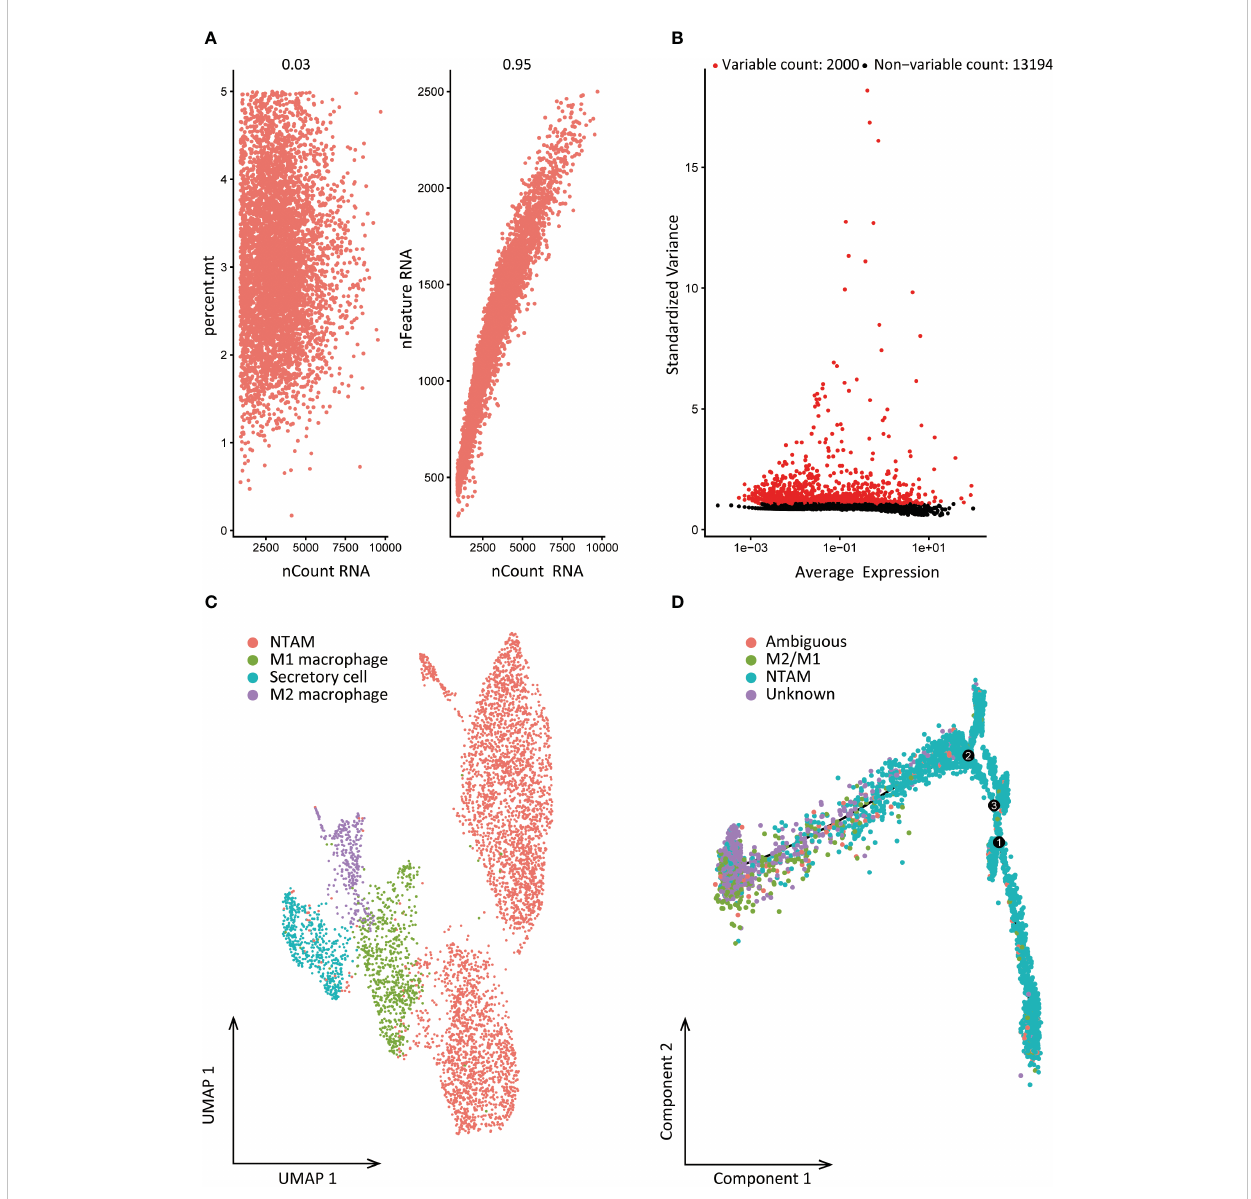
FIGURE 2 Cell clustering and differentiation trajectory analysis. (A) Correlation between sequencing depth and mitochondrial gene sequences or total intracellular sequences. (B) 15,194 genes were analyzed in total, of which 13,194 exhibited low intercellular variation and 2,000 had high intercellular variation. (C) Cell annotation based on gene markers. (D) Pseudo-time and trajectory analysis. PCA, principal component analysis; PCs, principal components; NTAMs, non-tumor-associated macrophages; UMAP, Uniform Manifold Approximation and Projection for Dimension